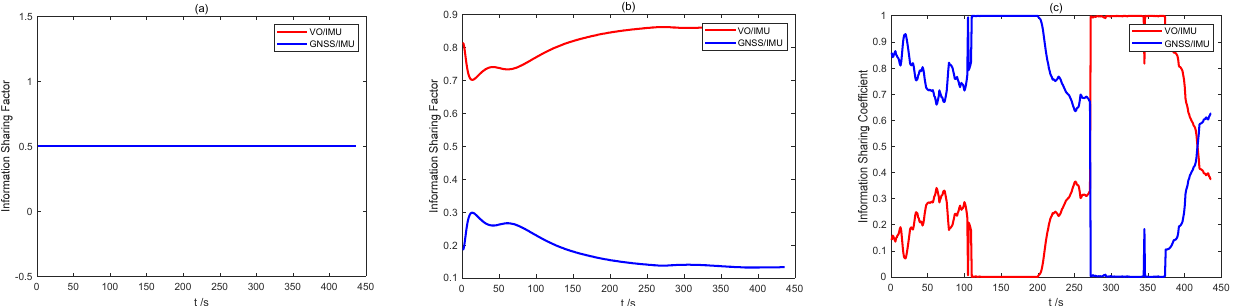
Figure 3. Comparison of information sharing coefficients of three schemes: ( a ) scheme 1; ( b ) scheme 2; and ( c ) scheme 3.